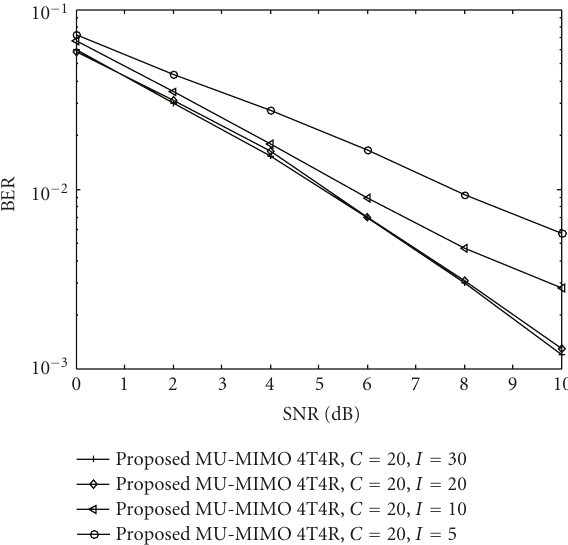
Figure 8: The BER comparison of the two schemes with di ff erent C and